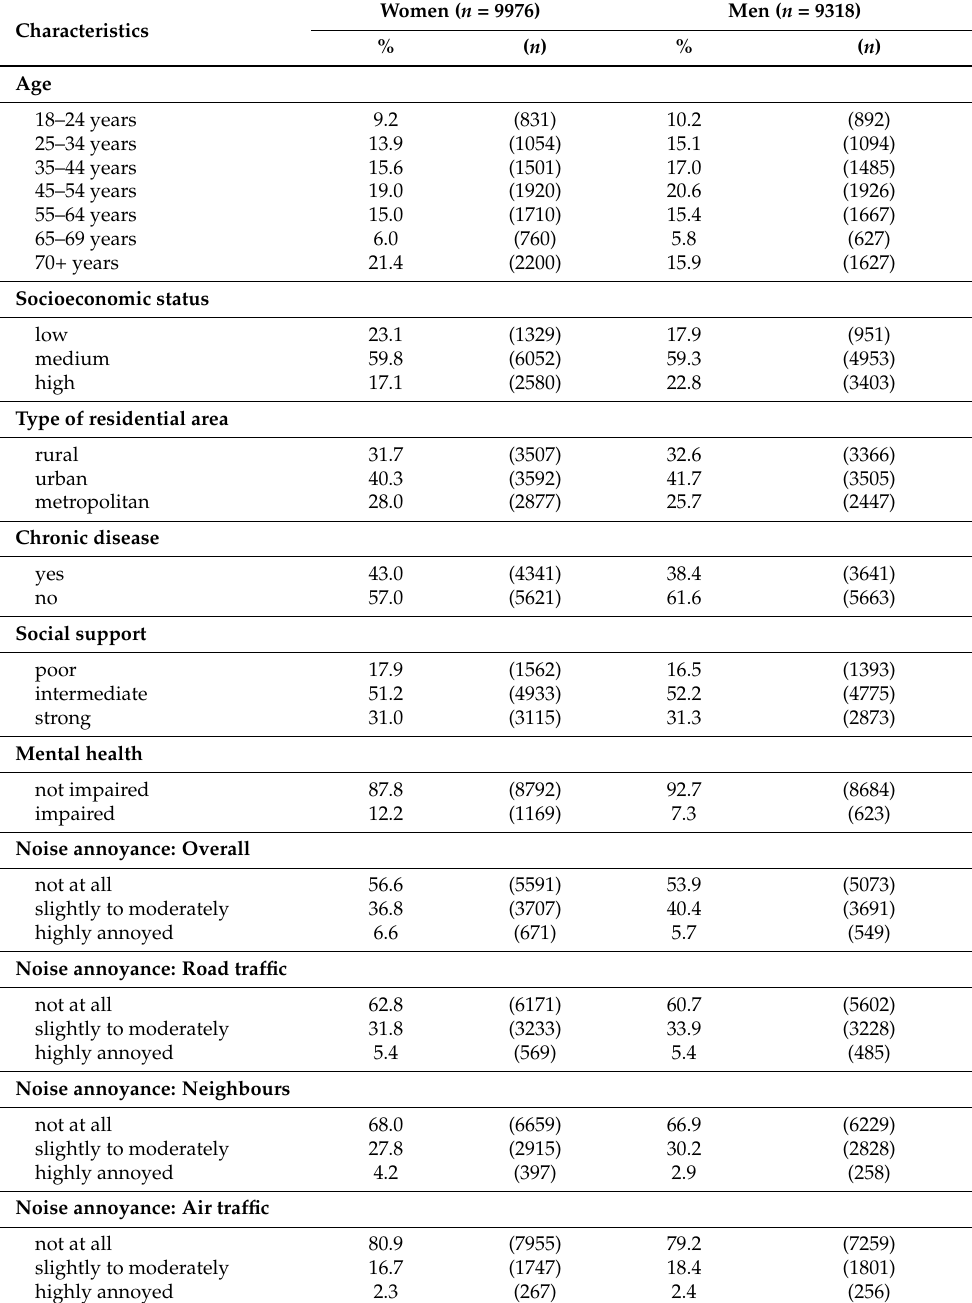
Table 1. Characteristics of the “German Health Update” study 2012 (GEDA 2012) study population ( n =